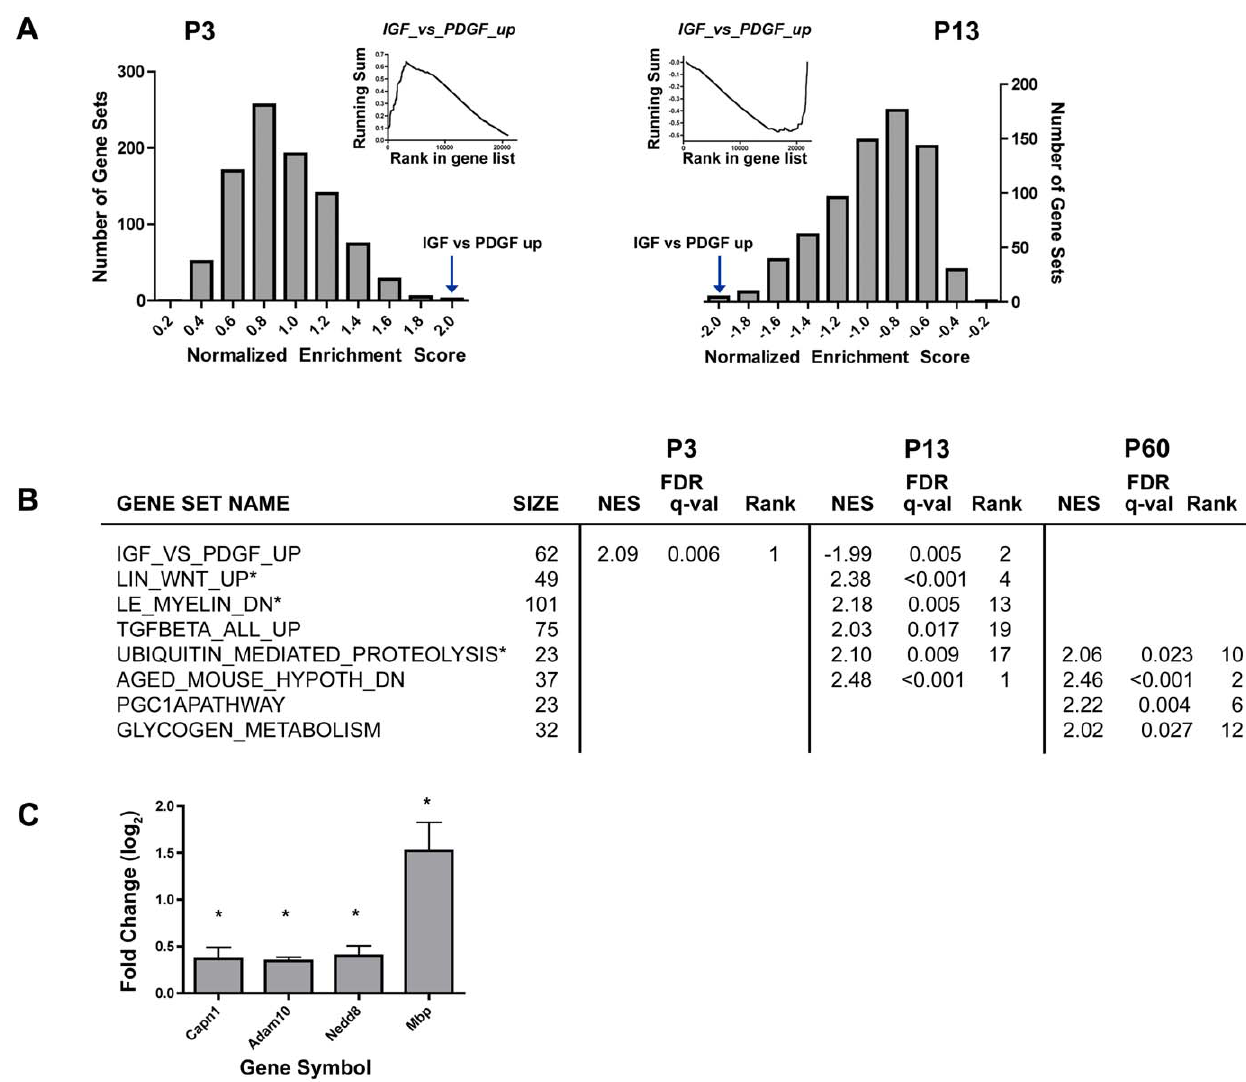
Figure 5. Gene set enrichment analysis of a 9 2 / 2 and wild type. ( A ) GSEA analysis of IGF1_vs_PDGF gene set. The inset depicts the running sum for the IGF1_vs_PDGF gene set at each gene in the rank-ordered list comparing a 9 2 / 2 and wild type at P60. The enrichment score is the maximum (up-regulated molecules) or minimum (down-regulated molecules) deviation from zero. The main plot shows the frequency distribution of normalized enrichment scores for all 1,390 gene sets. The arrow points to the bin that includes the IGF1_vs_PDGF gene set. ( B ) Several significantly differentially expressed gene sets with particular roles in synapse development or function are shown at P3, P13 and P60 (FDR q-value , 0.05). Rank indicates the position of the gene set when compared to all others (a total of 1,390). ( C ) Log 2 fold changes from qPCR validations are shown for four genes that were selected from three gene sets: Capn1 (LIN_WNT_UP), Adam10 and Mbp (LE_MYELIN_DN) and Nedd8 (UBIQUITIN_MEDIATED_PRO- TEOLYSIS). A significant change is denoted with an asterisk ( p , 0.05, two-tailed t -test). relevant samples. Specifically, single-channel gene expression data from three separate studies (GSE9803, GSE4040 and GSE4034) were downloaded from Gene Expression Omnibus (NCBI). All of the datasets were from mouse brain tissue samples hybridized to Affymetrix Mouse 430.2 chips. Twelve samples were from hippocampus, 9 from amygdala and 5 from striatum. Only data from wild type adult animals were considered, and data from specific mutants or treatments were excluded. The raw data were quantile-normalized as a group and filtered to remove probes with low expression variance across studies. Biclustering was performed on the resulting 22,550 probes and 29 samples using the Iterative Search Algorithm (ISA) as described [38] and as implemented by